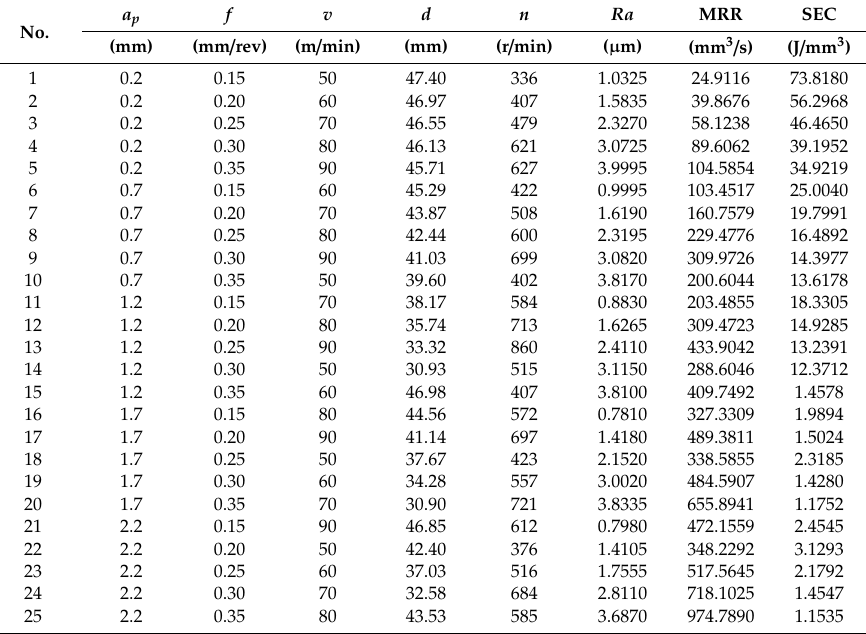
Table 4. Experiment design using L 25 (5 3 ) orthogonal array and their measurement